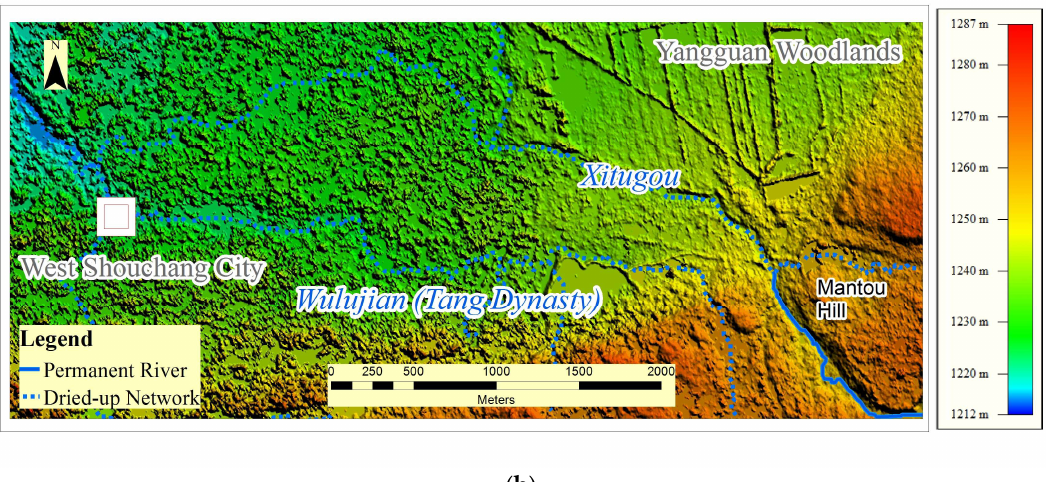
Figure 6. Dried-up watercourse of the Wulujian and the suspected location of West Shouchang City of the Tang Dynasty. ( a ) Extracted drainage network overlaid on the Gaofen-2 image; ( b ) extracted drainage network overlaid on the shaded relief model.